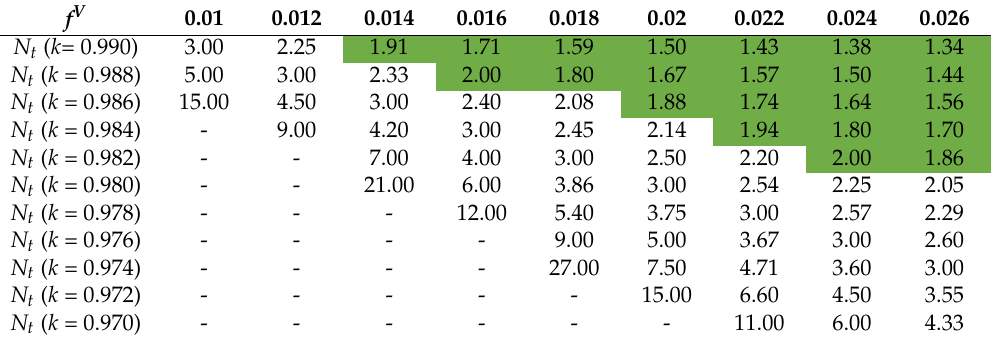
Table 3. The N t of the system in the case of N =